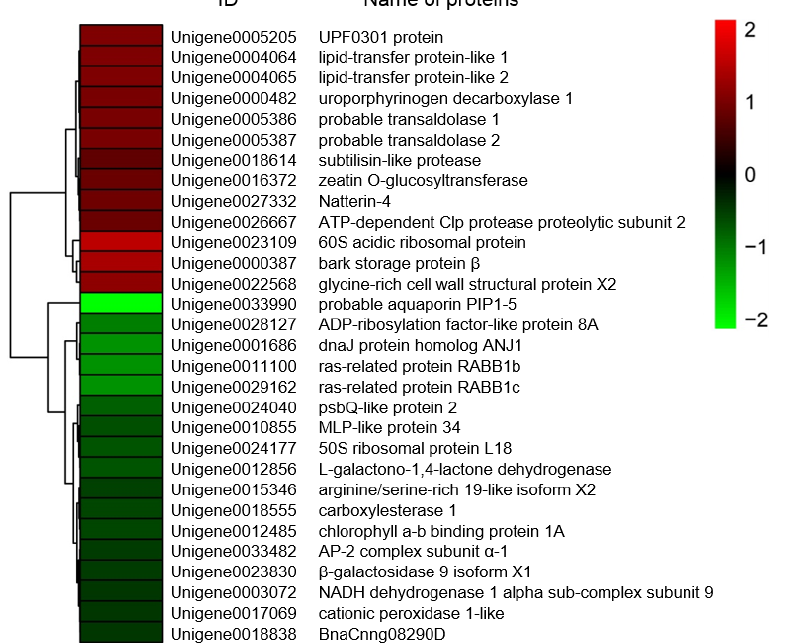
Figure 4. Heat map diagram of expression patterns for differentially expressed proteins in shoots of salt-treated sugar beet plants compared with untreated plants. The color scale bar in the right, bottom corner indicates increased (red) and decreased (green) levels in response to salt change.